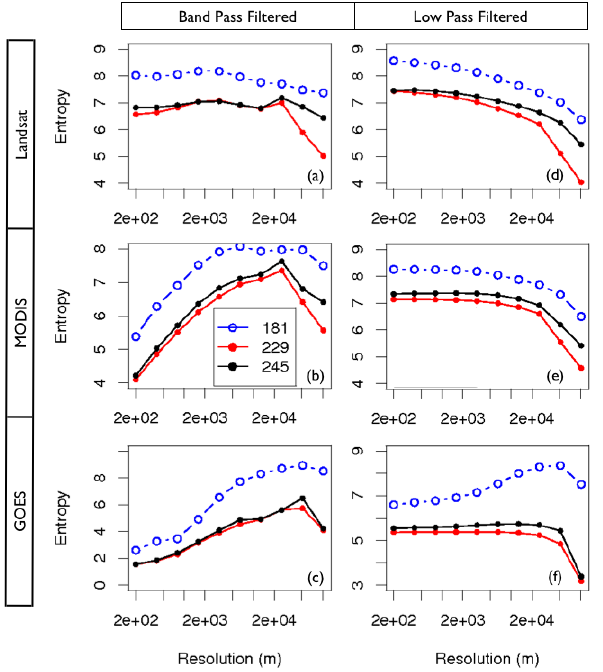
Fig. 6. Relative entropy between each scale of controlling variable (left) T rad and (right) Rn to the modeled ET flux from each sensor (top) Landsat (middle) MODIS and (bottom) GOES for each day.